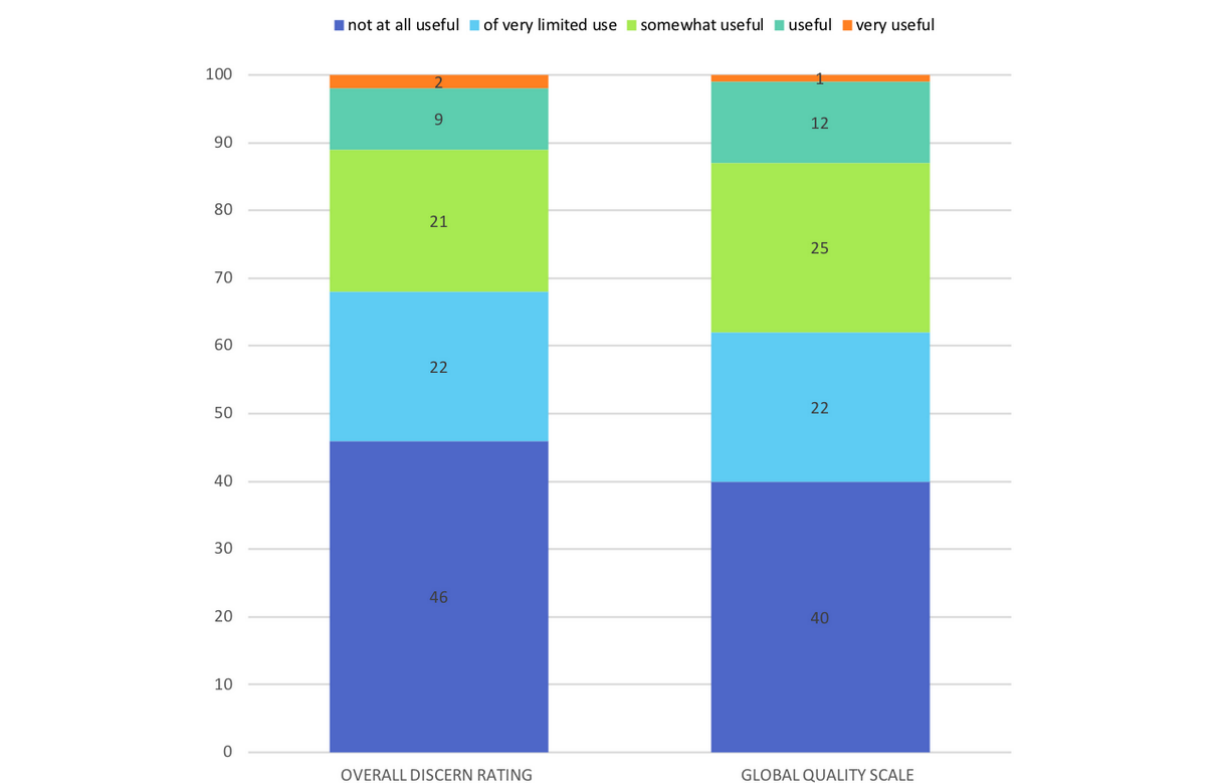
Figure 1. Comparison of the overall quality and usefulness of the identified videos (n=100) for patients seeking health-related advice, using the DISCERN instrument and the Global Quality Scale. The overall rating of DISCERN refers to question 16 of this tool, which is based on a 5-point scale (Multimedia Appendix